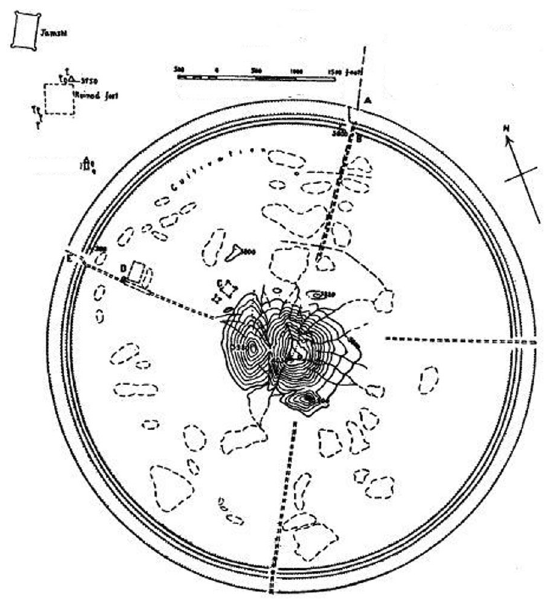
Fig. 2 Plan of Darabgerd (Source: Karimian and Seyedein 2009,